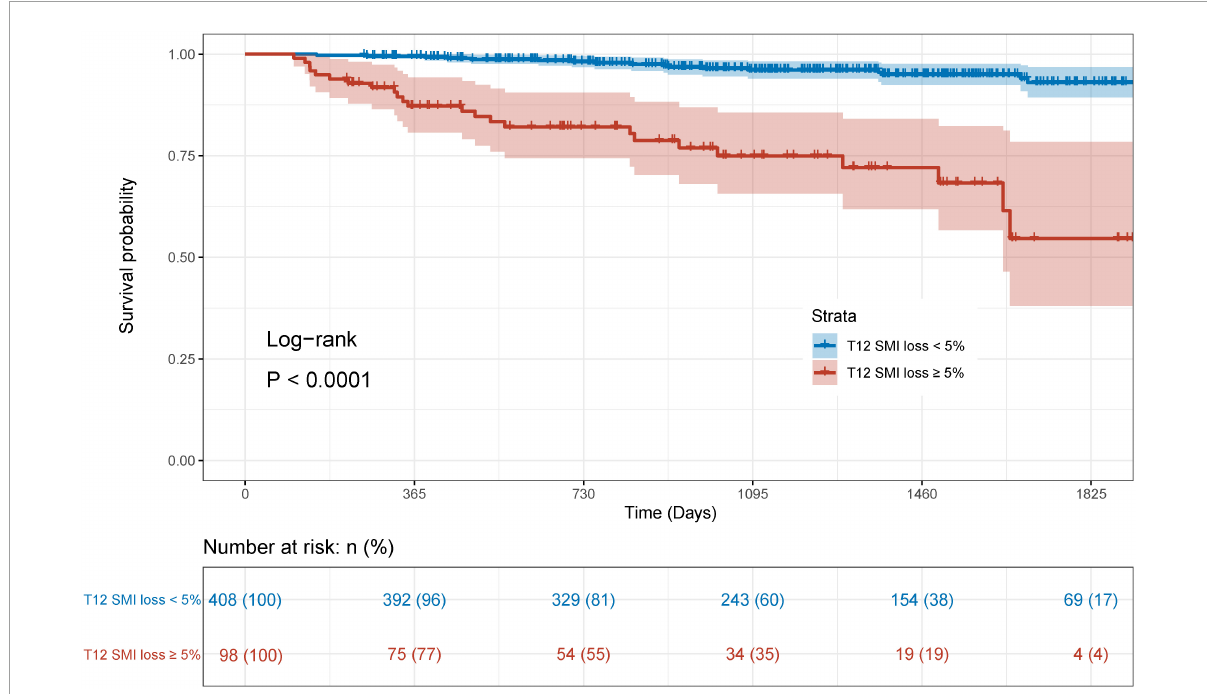
FIGURE3 Kaplan-Meier curve for overall survival stratified by postoperative skeletal muscle mass